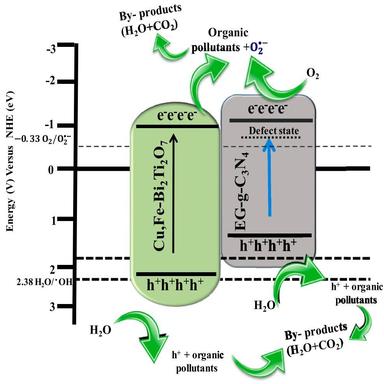
Band alignment and possible degradation mechanism of the Cu, Fe-BTO/EGCN Hetero-structured photo-catalyst.